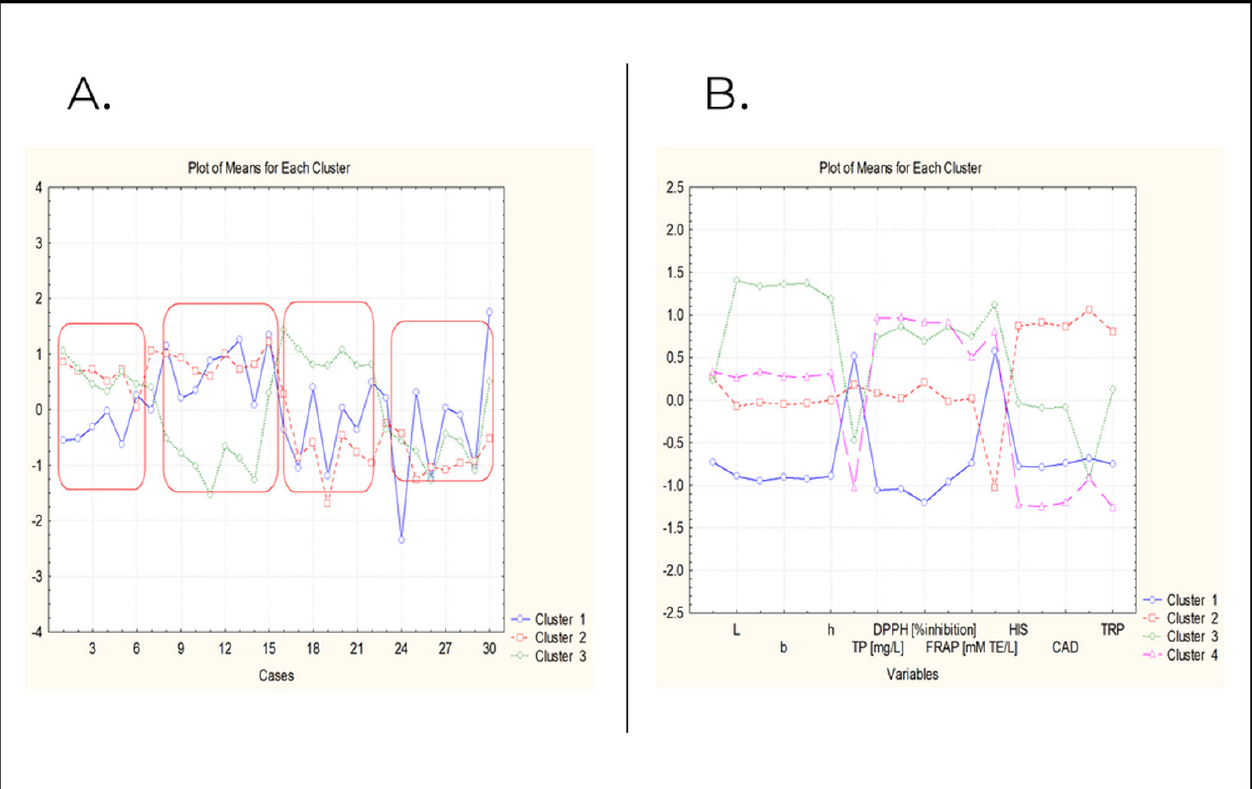
Figure 3. ( A ) Plot of average values for each cluster of variables for each object wine sample. ( B ) Plot of average values of each variable for each identified cluster. The sequence of variables is as follows: pH, L*, a*, b*, C*, H*, logN, TP, TA, DDPH, ABTS, FRAP, 2-PE, HIS, PUT, CAD, TYR, TRP. TRP—